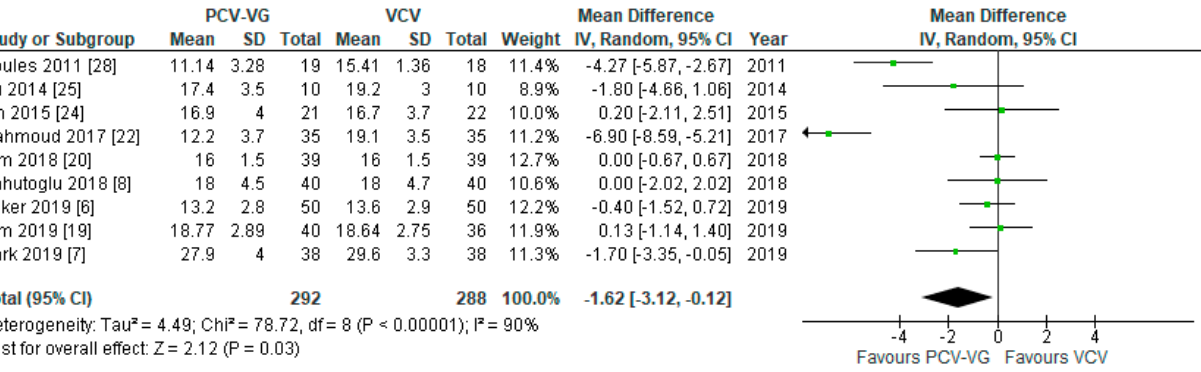
Figure 5. Plateau airway pressure (P plateau ): supine, two-lung ventilation. The green center of each square represents the weighted mean difference for individual trials, and the corresponding horizontal line stands for a 95% confidence interval. The diamonds represent pooled results.